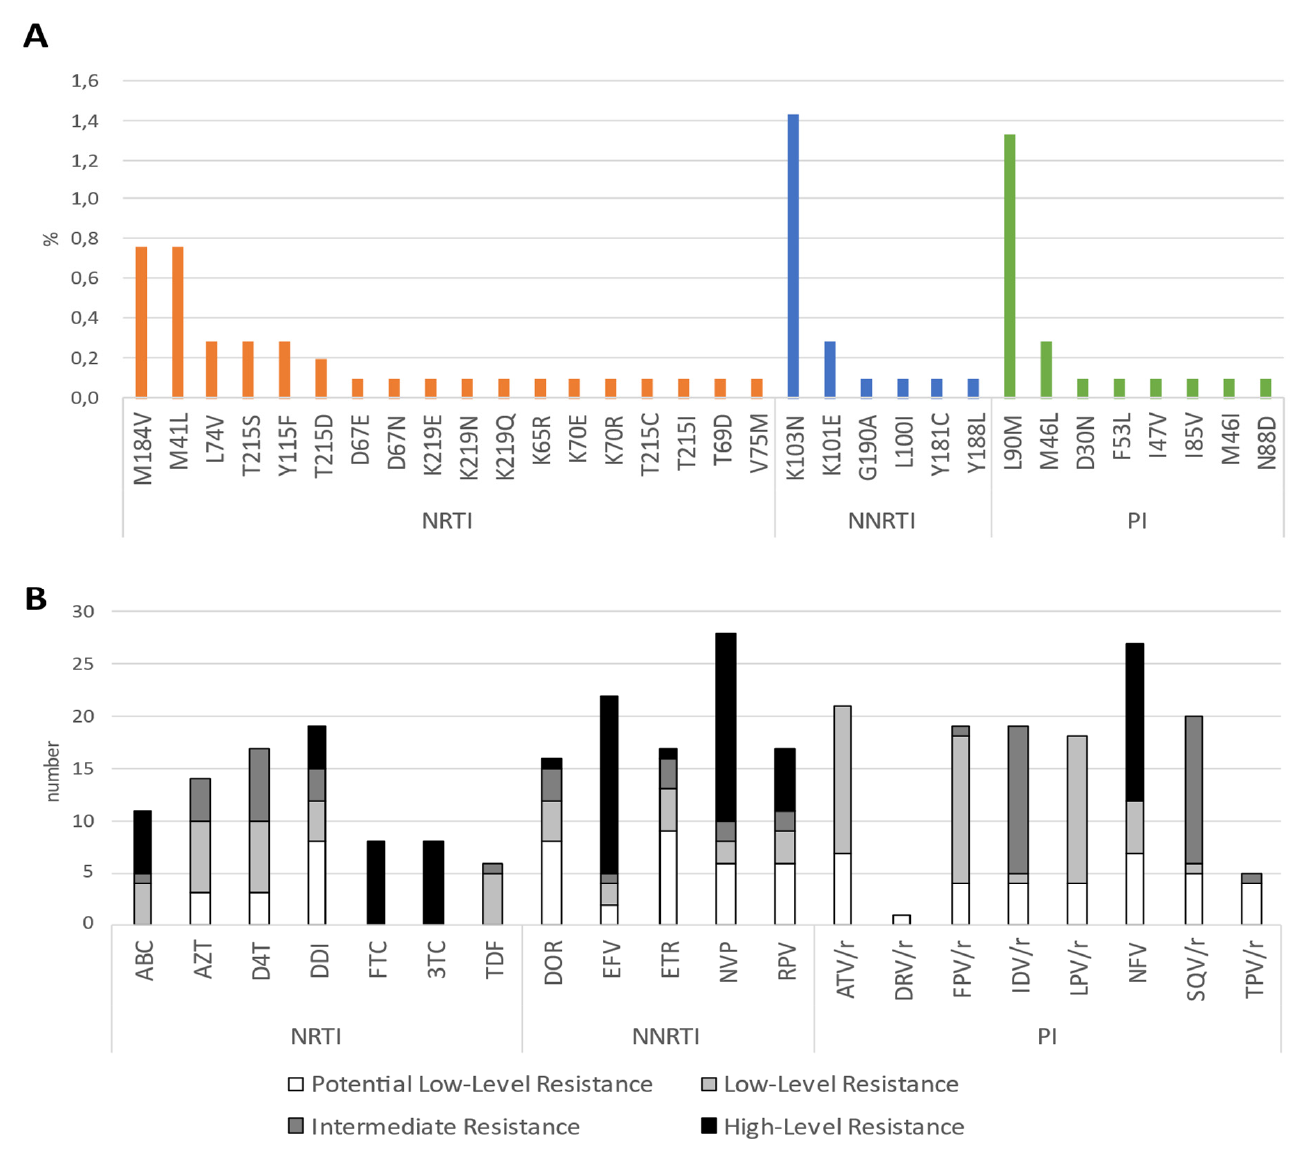
Figure 1. Transmitted drug resistance in Bulgaria and predicted phenotypic resistance. ( A ) Proportion of specific drug resistance mutations in the HIV-1 polymerase sequences of newly diagnosed, antiretroviral-naive patients and ( B ) Number of patients with predicted phenotypic resistance based on Stanford scores to specific antiretroviral drugs. NRTI, nucleoside reverse transcriptase inhibitor; NNRTI, non-nucleoside reverse transcriptase inhibitor; PI, protease inhibitor. ABC = abacavir, AZT = zidovudine, D4T = stavudine, DDI = didanosine, FTC = emtricitabine, 3TC = lamivudine, TDF = tenofovir disoproxil fumarate, DOR = doravirine, EFV = efavirenz, ETR = etravirine, NVP = nevirapine, RPV = rilpivirine, ATV/r = ritonavir-boosted atazanavir, DRV/r = ritonavir-boosted darunavir, FPV/r = ritonavir-boosted fosamprenavir, IDV/r = ritonavir-boosted indinavir, LPV/r = ritonavir-boosted lopinavir, NFV = nelfinavir, SQV/r = ritonavir-boosted saquinavir, TPV/r = ritonavir-boosted tipranavir.